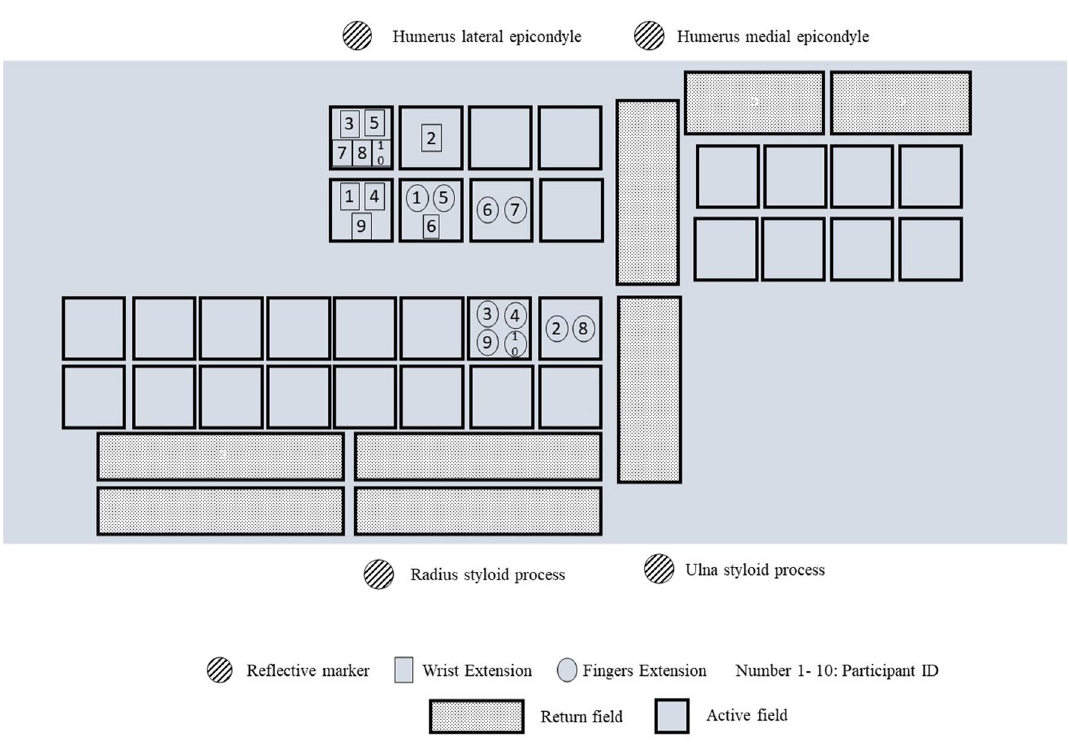
Figure 2. Representation of the active fields selected for each